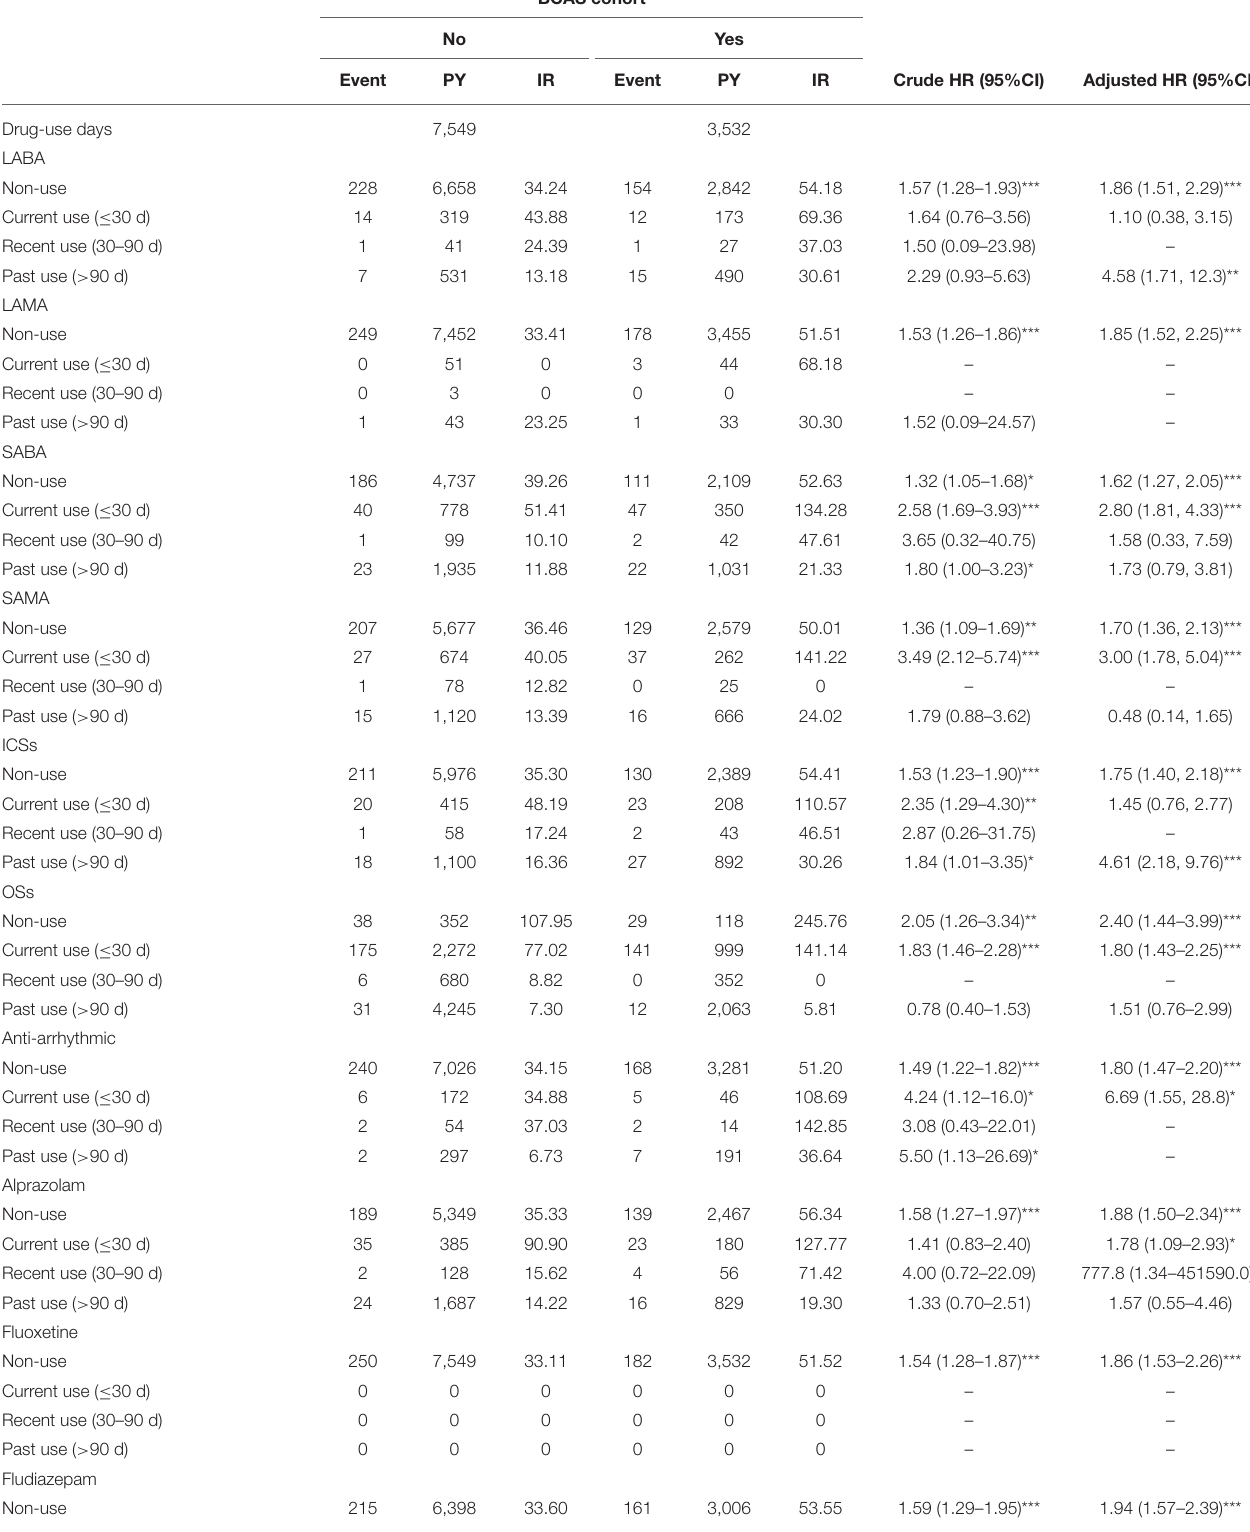
TABLE 4 | Incidence rate and hazard ratio of ischemic stroke or heart-disease between two cohorts stratified by current, recent and past